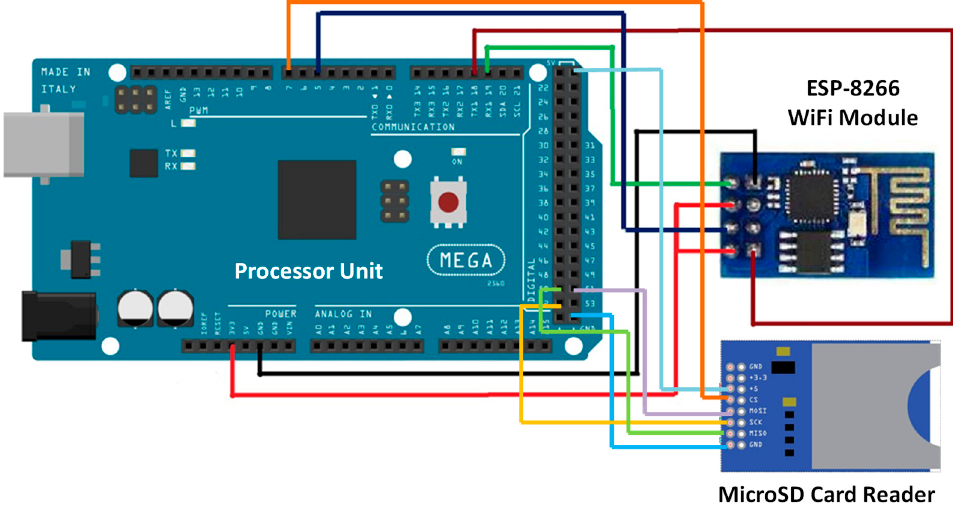
Figure 9. Compatible module with Arduino Mega 2560 connected to WiFi module and MicroSD card reader.